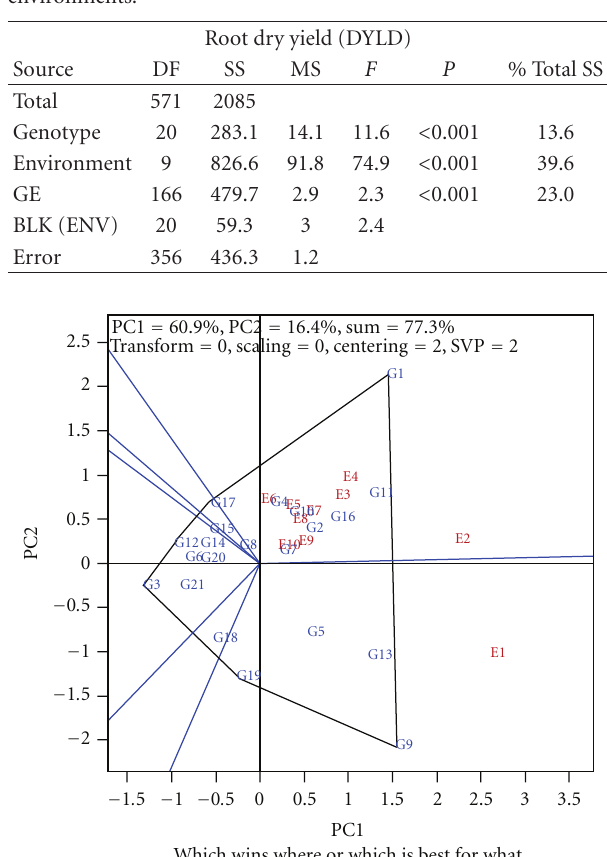
Figure 4: Megaenvironments defined by di ff erent winning yellow- fleshed cassava genotypes tested in 10 environments for the average DYLD (tha − 1 ).